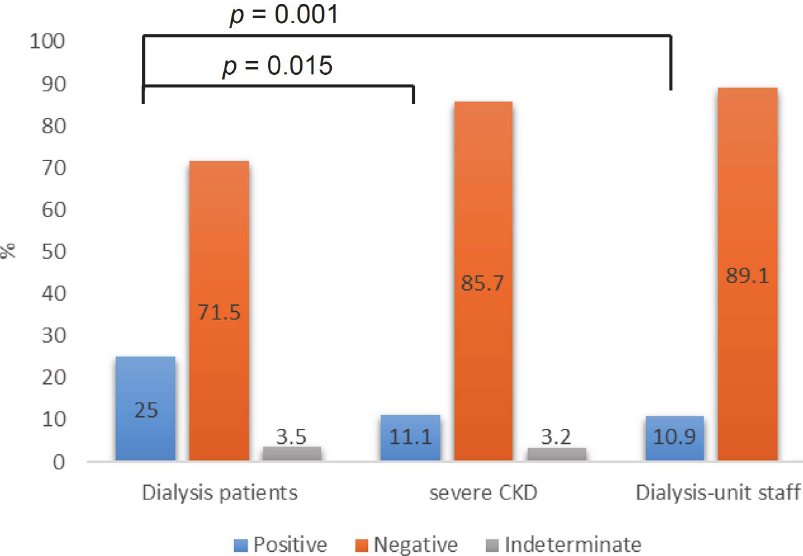
Fig 1. The results of QuantiFERON-TB Gold In-tube (QFT-GIT) in subjects with severe chronic kidney disease (CKD), dialysis-unit (hemodialysis room) staff, and patients undergoing long-term hemodialysis.